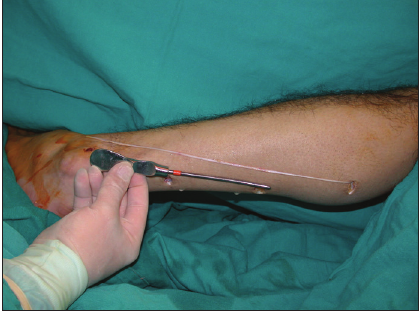
Figure 4. This process was continued until the desired length of the nerve graft was obtained.